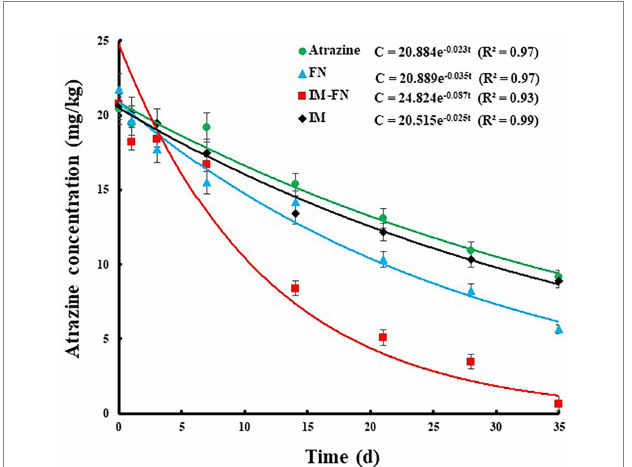
FIGURE 8 Degradation effect of atrazine in soil treated with atrazine, bacterial suspensions (FN), immobilized bacterial mixture (IM-FN), and immobilized carrier materials (IM).